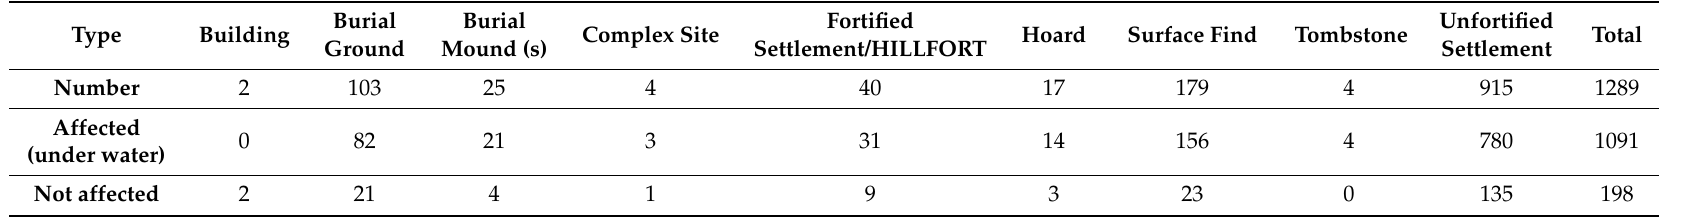
Table 2. Distribution of cultural heritage sites around Kuibyshev reservoir according to their typology.